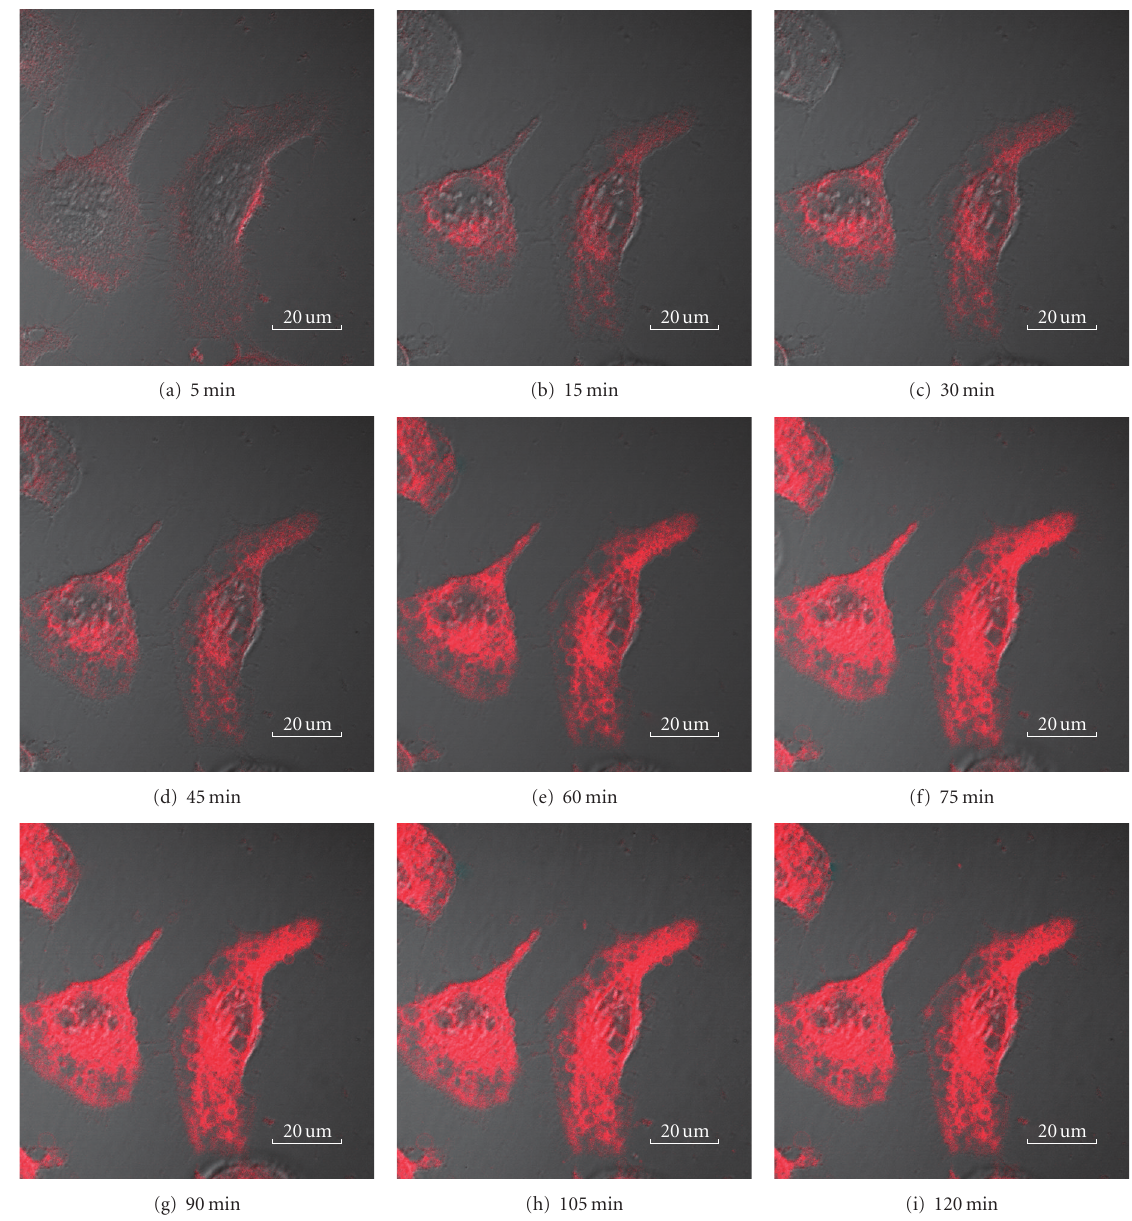
Figure 4: LSCM images of CPD4 uptake in MCF-7 cells at di ff erent incubation